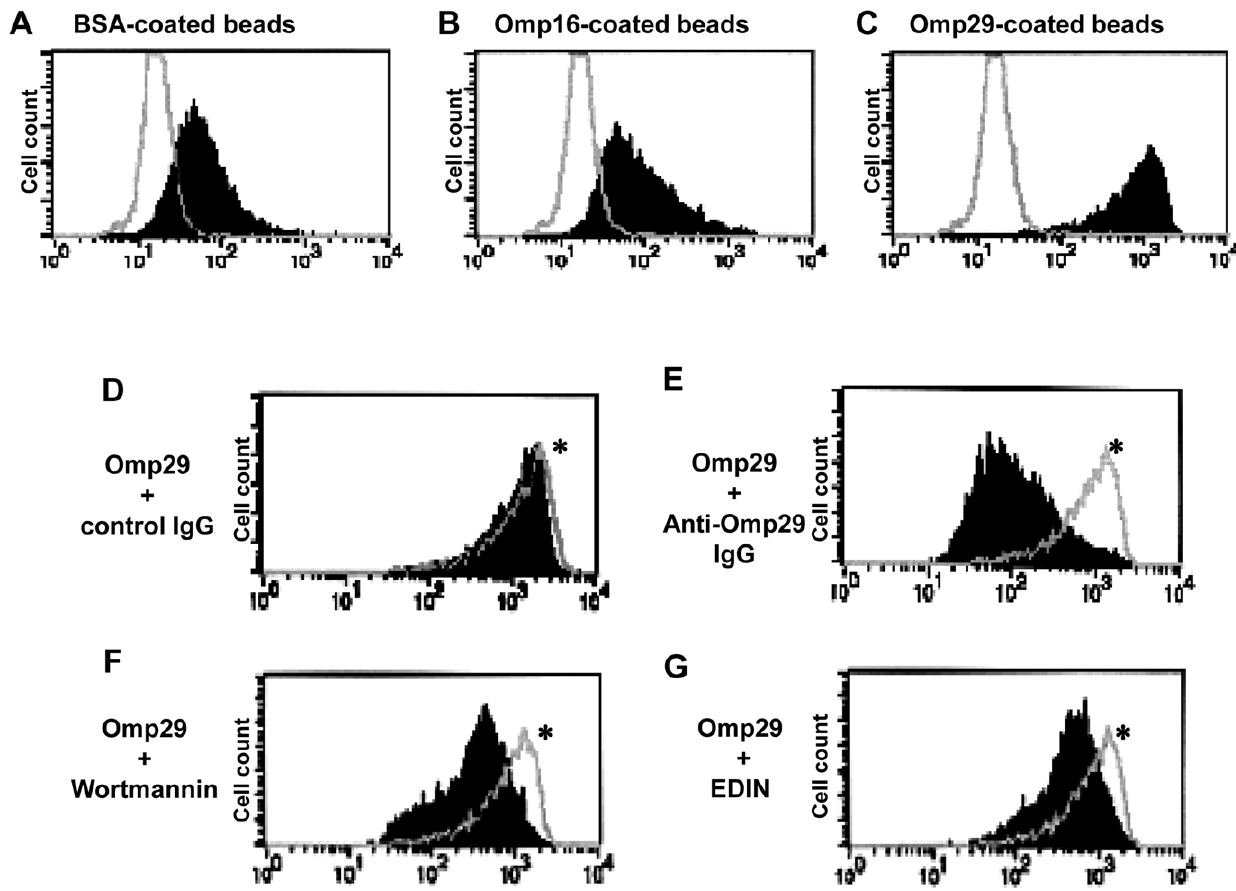
Figure 6. Influence of Rho GTPase inhibitor and PI-3-kinase inhibitor on internalization of Omp29-coated beads into OBA9. (A–C) Confluent OBA9 cells cultured in tissue culture plate were incubated with or without BSA-coated fluorescent Latex beads (FLB) (A), Omp16-coated FLB (B), or Omp29-coated FLB (C) for 4 hours. The open histogram indicates non-treated OBA9 and the solid histogram display the internalization of indicated FLB, respectively. (D–G) Omp29-coated FLB were incubated with OBA9 cells for 4 hours in the presence or absence of control serum IgG 10 m g/ml (D), anti-Omp29 serum IgG 10 m g/ml (E), Wortmannin 10 nM (F), or EDIN 100 ng/ml (G). Open histogram * indicates the internalization of Omp29-coated FLB in OBA9 incubated with medium alone. The solid histogram display the incorporation of Omp29-coated FLB treated with IgG or inhibitory agents, respectively. Anti-Omp29 serum IgG, Wortmannin and EDIN inhibited 97%, 73% and 66% of Omp29-coated FLB internalization into OBA9 cells, as determined by mean fluorescent intensity.